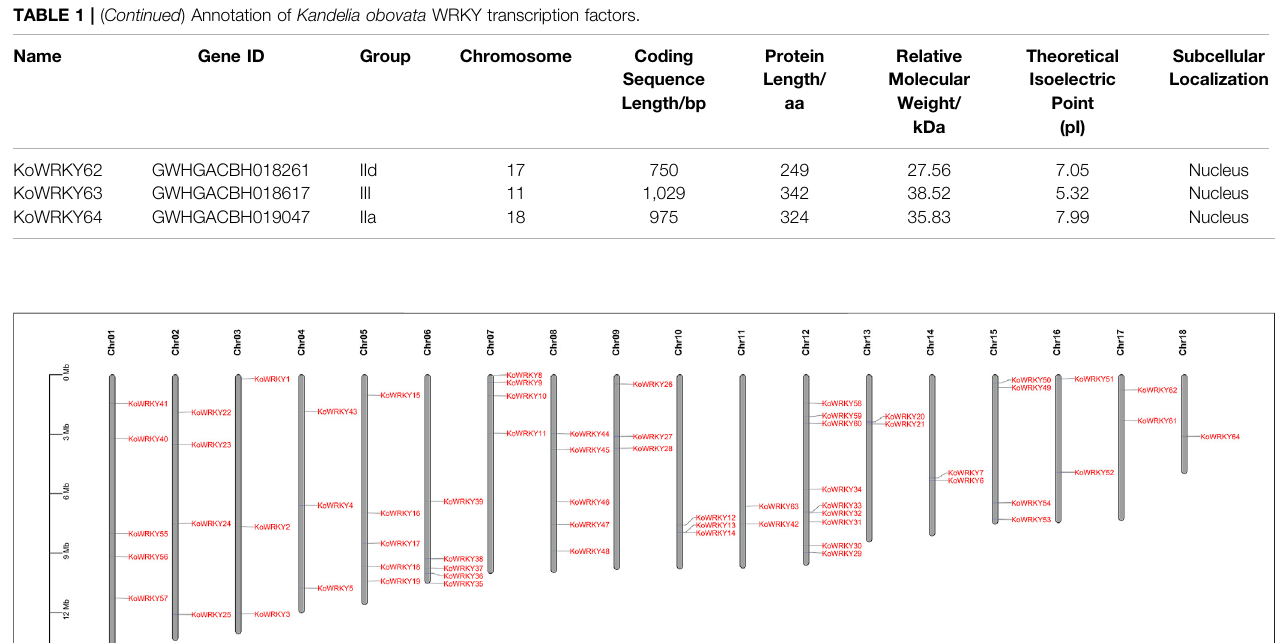
Frontiers in Genetics |